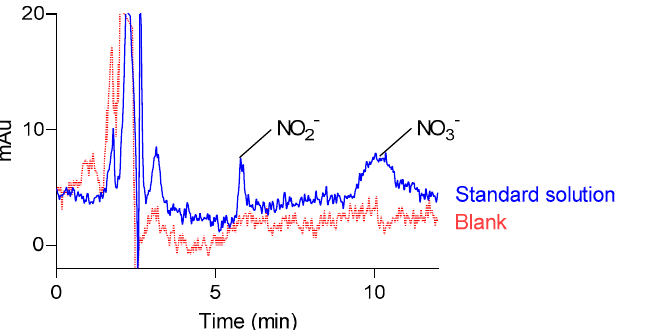
Figure 3. Limits of quantification for nitrite and nitrate (3 and 30 µg/L, respectively) by IT − SPME − IE − CapLC − DAD.